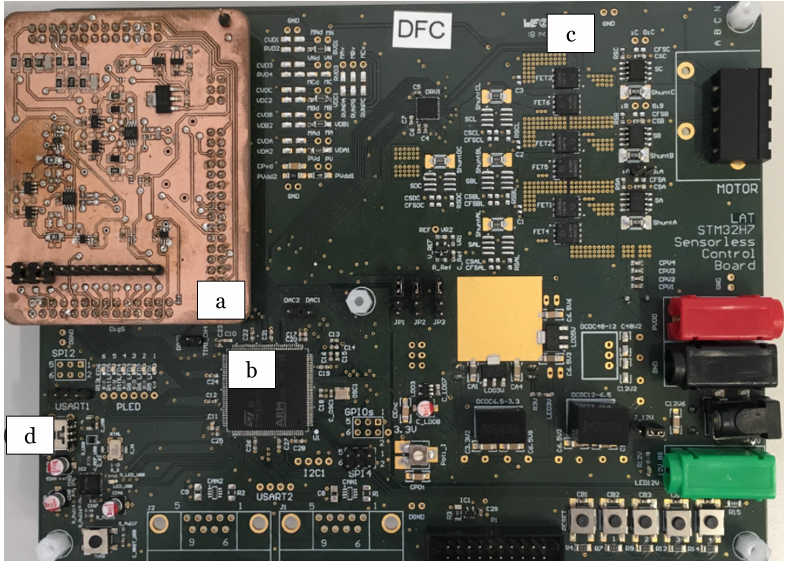
Figure 13. Electronic board used for the drive, control and measurement of the PMSM. ( a ) Board ex- tension with DFC electronic for the measurement of the star-point. ( b ) STM32H7 microcontroller. ( c ) Three-phase inverter and current sensors. ( d ) USB port for external communication and data transfer.